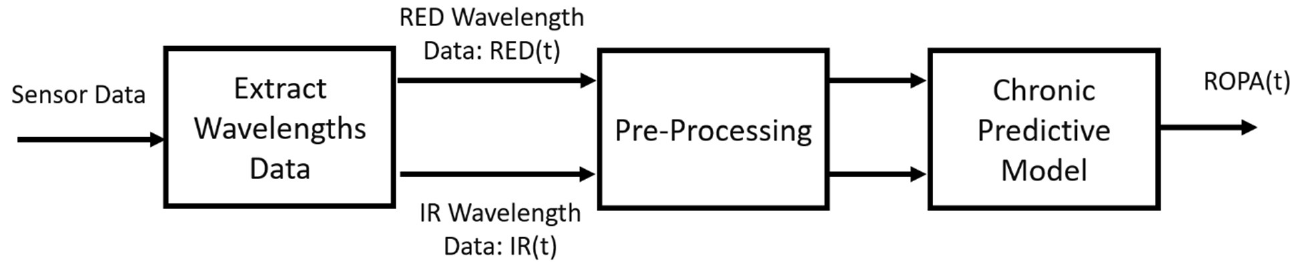
Figure 1. The pipeline for the signal processing applied to calculate the ROPA index.